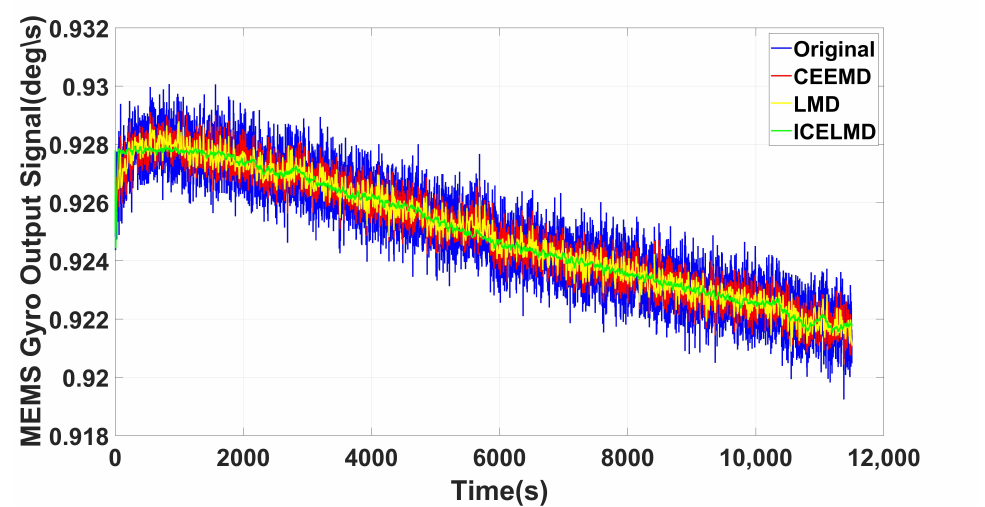
Figure 12. Denoising effects of different methods.